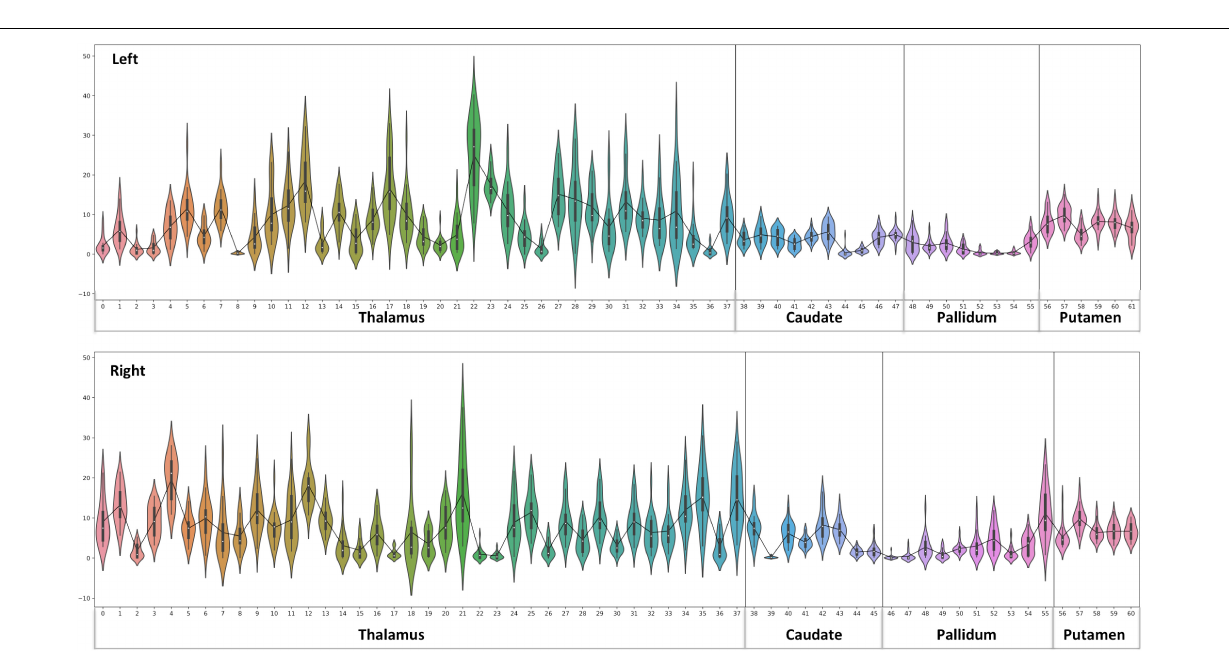
Frontiers in Neuroanatomy |